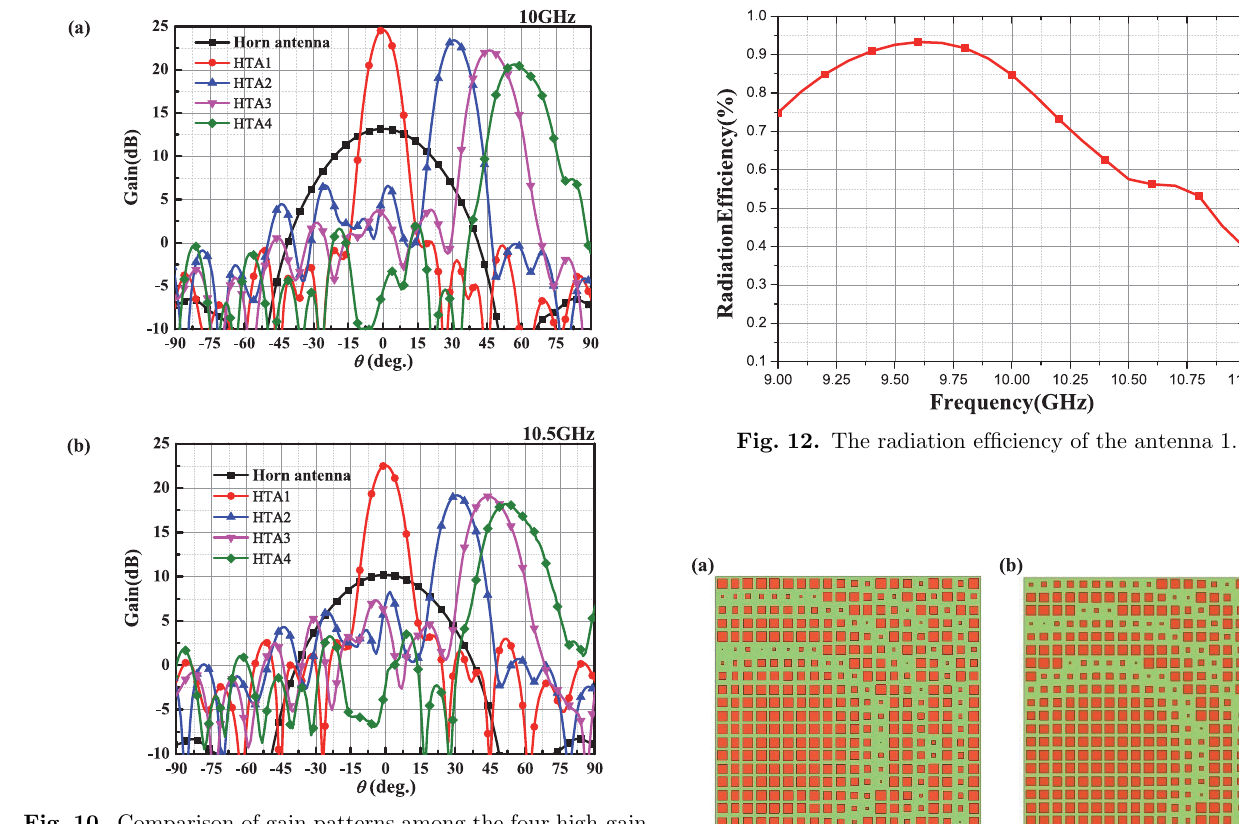
Fig. 10. Comparison of gain patterns among the four high-gain antennas and the feeding source horn antenna, (a) 10GHz, and (b) 10.5 GHz.